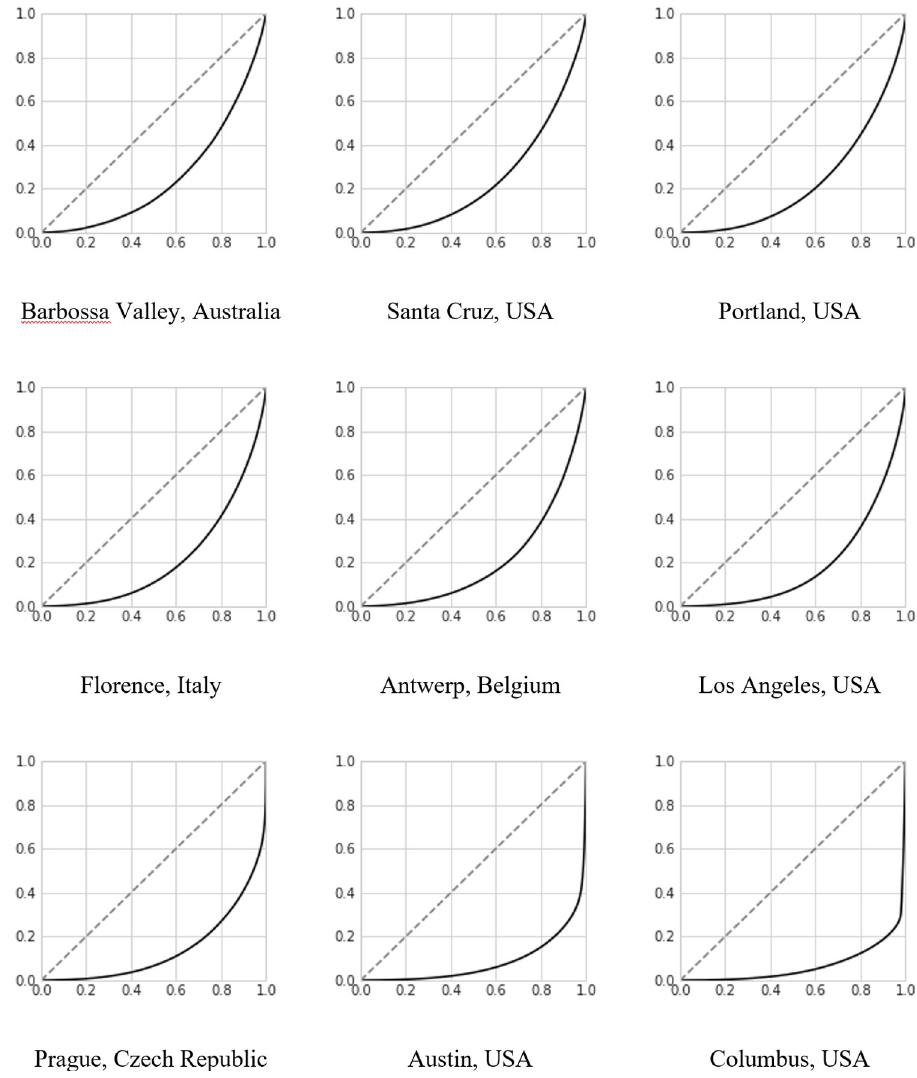
Fig 2. The Lorenz curves for the three cities with lowest, median and highest Gini coefficients, respectively. The Lorenz curve shows the cumulative fraction of the population on the x-axis, and the cumulative fraction of the revenue taken by this population on the y-axis. For instance, looking at Prague, that the line is at y = 0.3 at x = 0.8 tells us that 80% of the hosts receive around 30% of the revenue. The dashed line shows the distribution that corresponds to everyone taking an equal share. (Gini is defined as the area between the straight and the curved line divided by the entire area under the straight